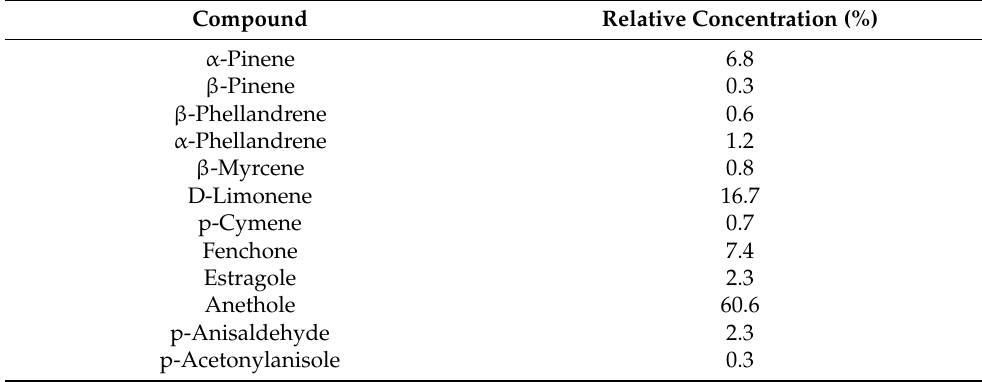
Table 1. Percentage composition of the fennel essential oil used in the present study.